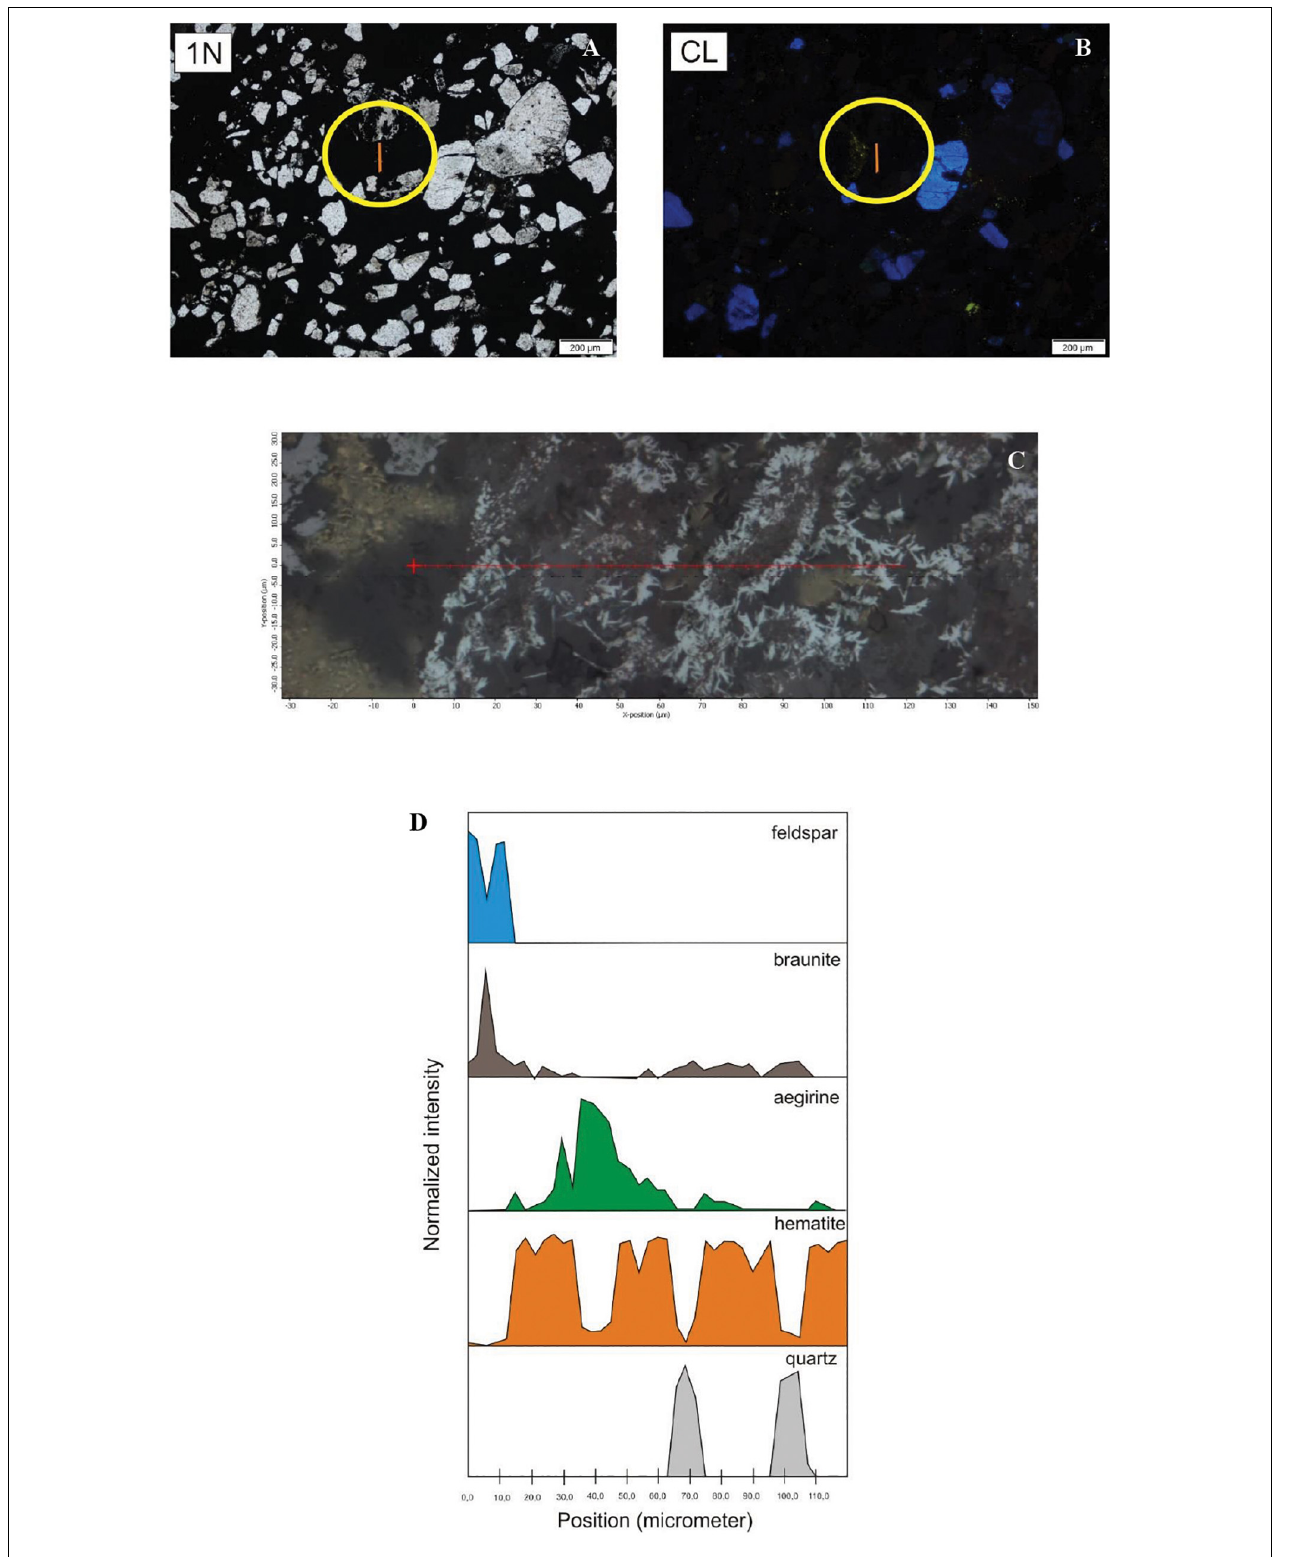
FIGURE 8 | Distribution of minerals along a section in the matrix material in sample COR-10 by Raman spectroscopy (yellow line showing the section in the circle). (A) Transmitted light photo by 1N. (B) CL image. (C) The analyzed section marked by red line. (D) Mineral distribution along the section.